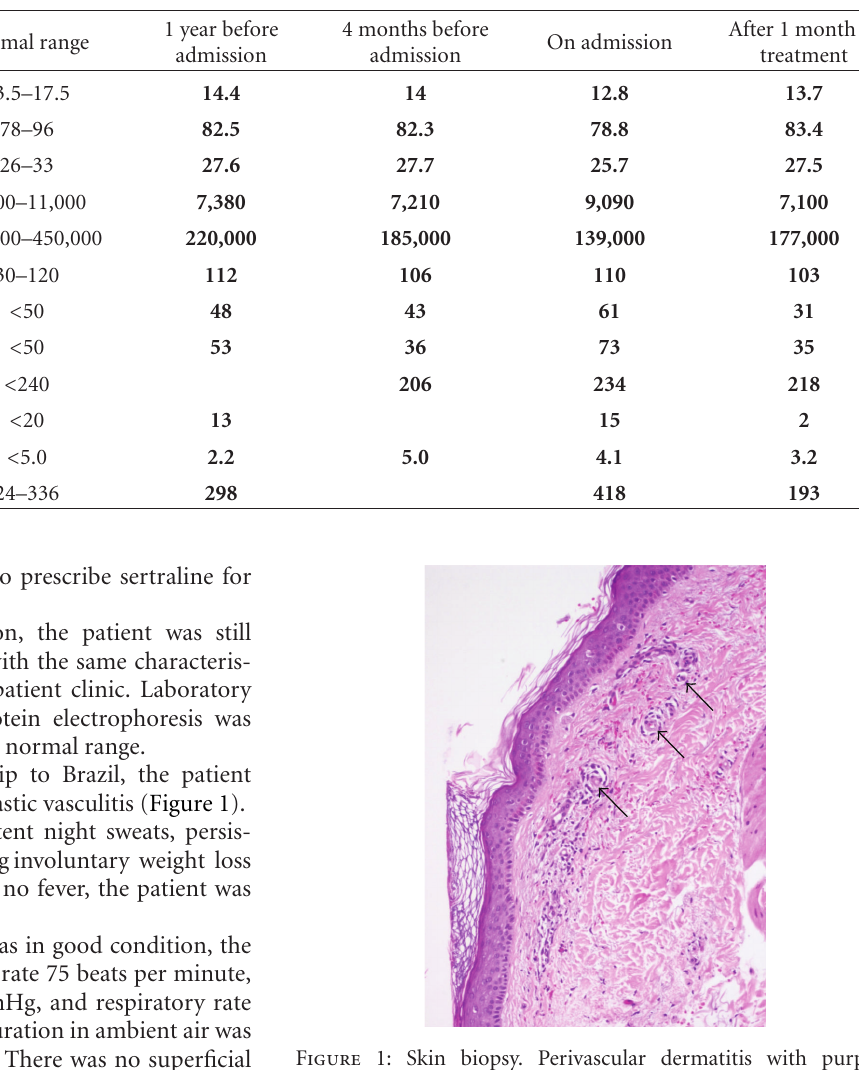
Table 1: Laboratory tests.